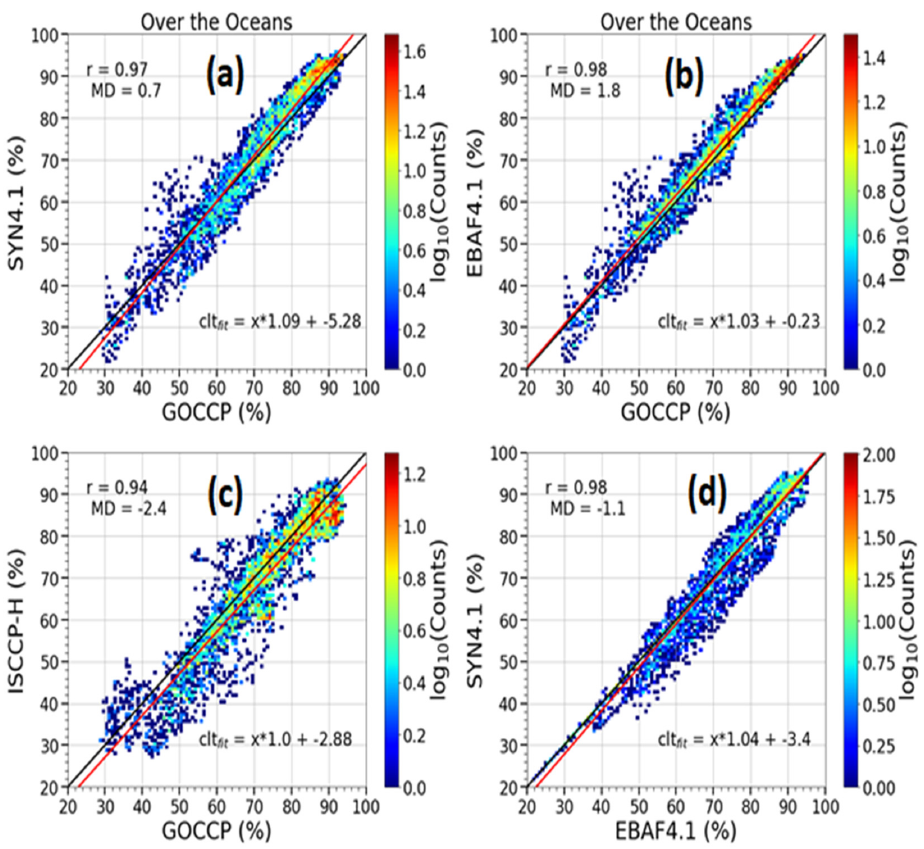
Figure 3. The same as Figure 1, but over the oceanic regions.